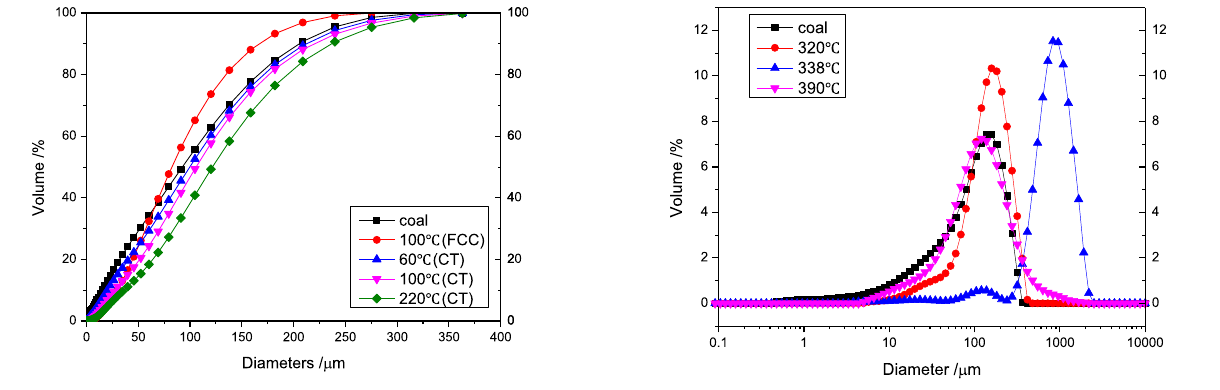
Fig. 8 The particle size of coal particles after